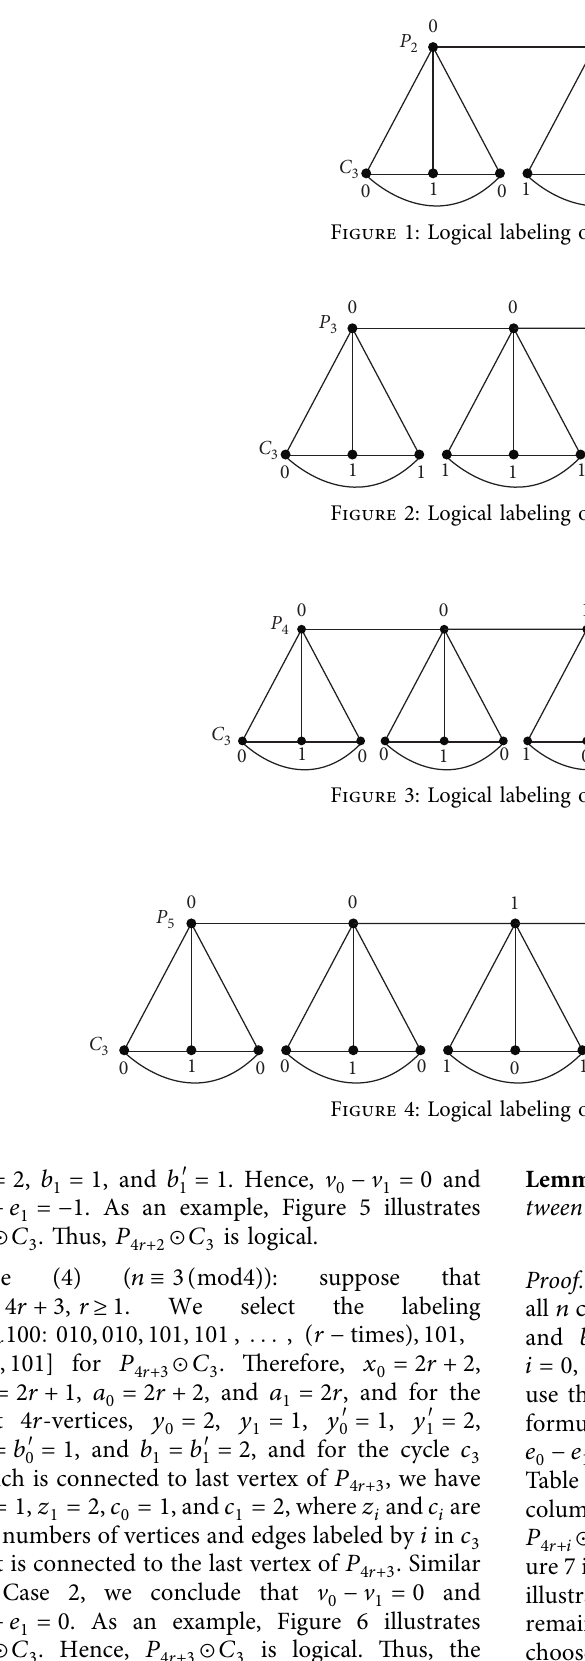
Figure 1: Logical labeling of P